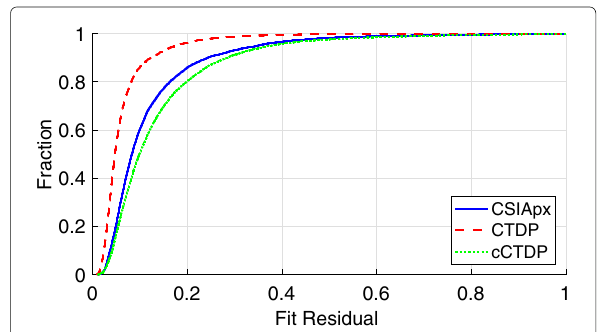
Fig. 5 Fit residual with experimental data. A comparison of the cumulative density function (CDF) of the fit residual per point is shown when running CSIApx versus CTDP. In addition, a comparison is also shown when running a constrained version of CTDP